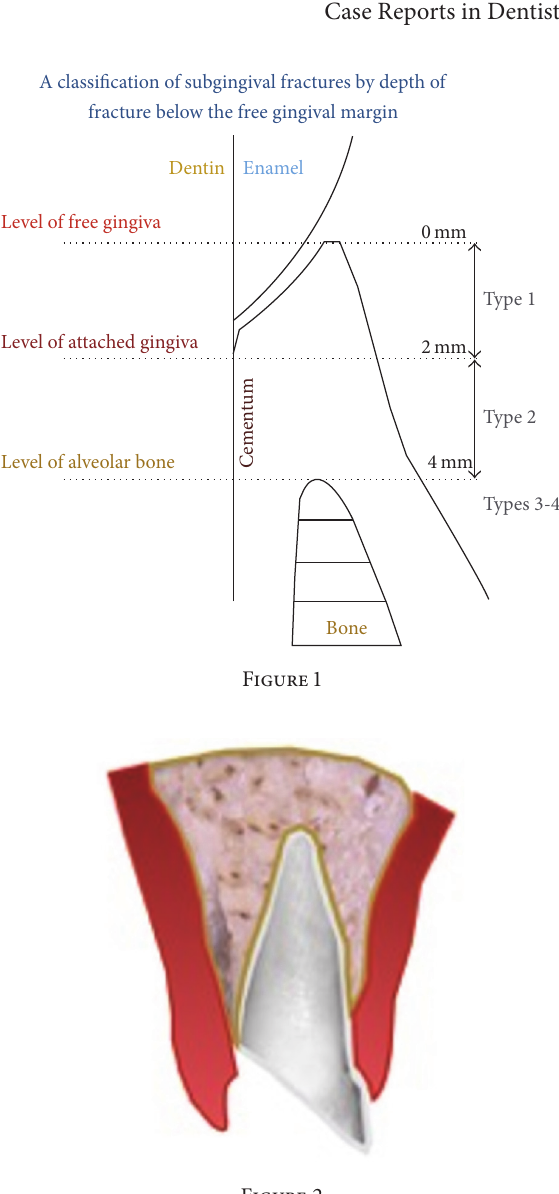
amount of remaining tooth structure, secondary traumatic injuries, occlusion, and aesthetics [3,